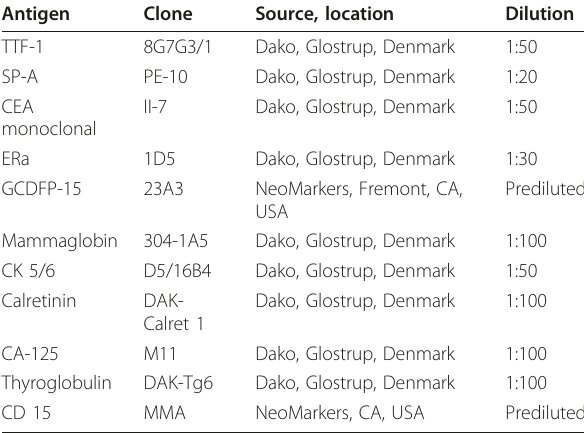
Table 1 Antibodies employed in the immunohistochemistry applied